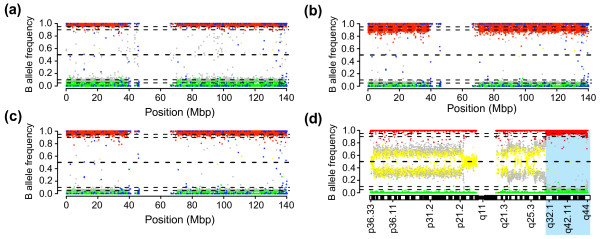
Effects of quantile normalization on allelic intensity ratios. Two urothelial carcinomas, UC456_R and UC152_I, analyzed using Infinium 370 k BeadChips are shown. SNPs have been colored based on individual genotype calls: AA (green), AB (yellow), BB (red), CNV probes (blue) and no calls (gray). Horizontal dashed lines represent BAF 0.05, 0.1, 0.5, 0.9 and 0.95, respectively. (a) BeadStudio normalized B allele frequency profile for chromosome 9 of UC456_R. (b) QN normalized B allele frequency profile for chromosome 9 of UC456_R. Compared to BeadStudio (a), QN increases variation for SNPs close to 1 in BAF and decreases variation for SNPs close to 0 in BAF. (c) tQN normalized B allele frequency profile for chromosome 9 of UC456_R. Application of a threshold for the increase in intensity of X and Y by QN lowers the variation of SNPs close to 1 in BAF compared to QN alone (b), and creates BAF values that are more symmetrical around BAF = 0.5 compared to BeadStudio (a). (d) tQN normalized B allele frequency profile for chromosome 1 of UC152_I. The region 1q32.1 to qter discussed in the text is highlighted with a light blue background. CNV probes have been removed.